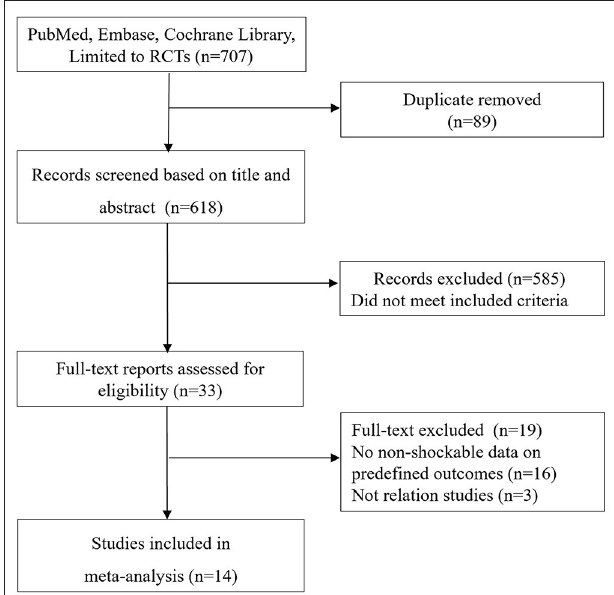
FIGURE 1 | Selection process for studies included in the